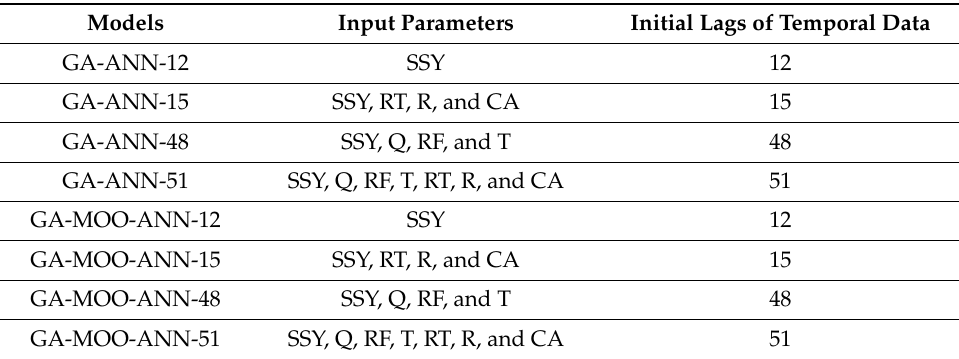
Table 4. Different types of models use various input parameters with